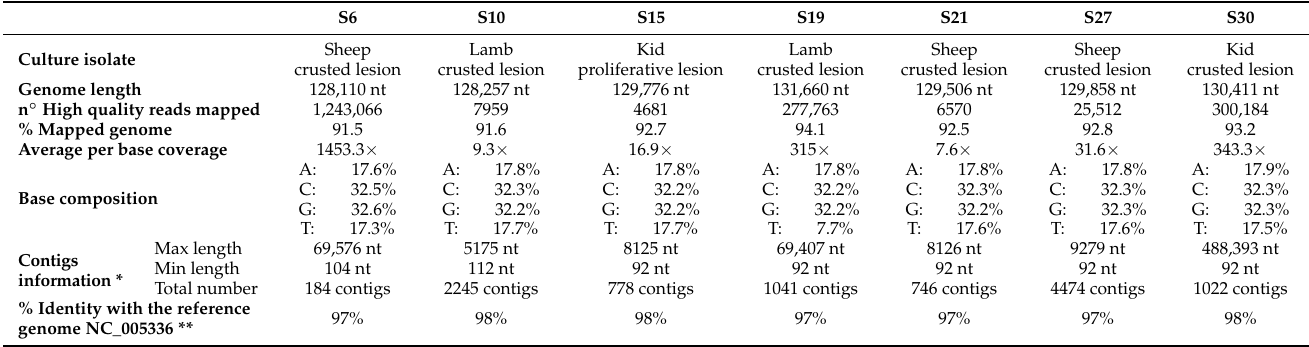
Table A1. Information regarding the seven ORF virus whole genome sequences isolated in hosts